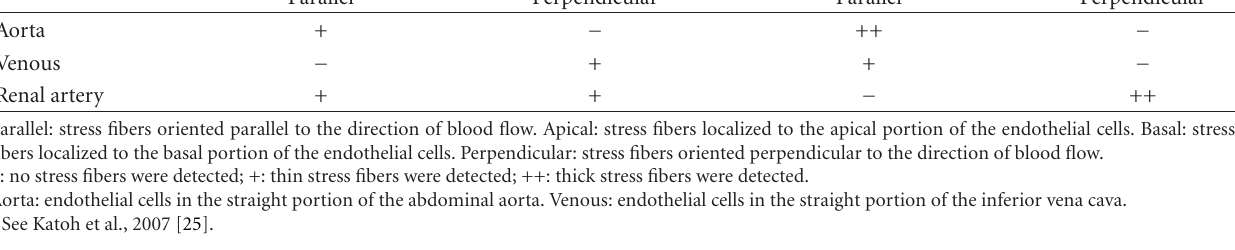
Table 1: Orientations of stress fibers in aortic, venous, and renal arterial endothelial cells.